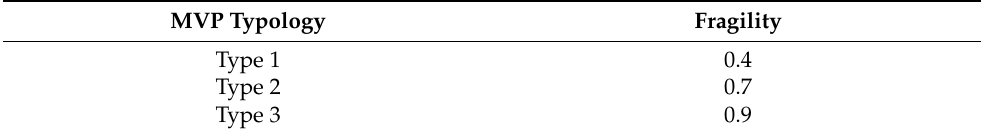
Table 2. K F,MVP values for MVP typology.